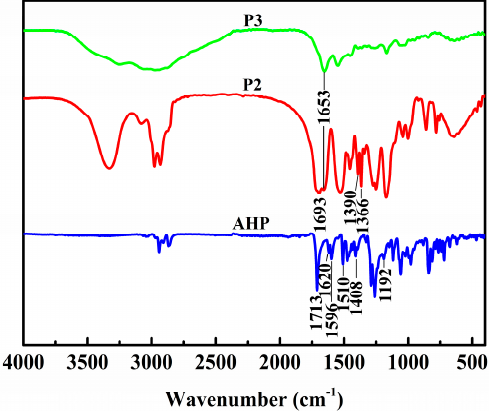
Figure 4. FTIR spectra of AHP, P2 , and P3 .